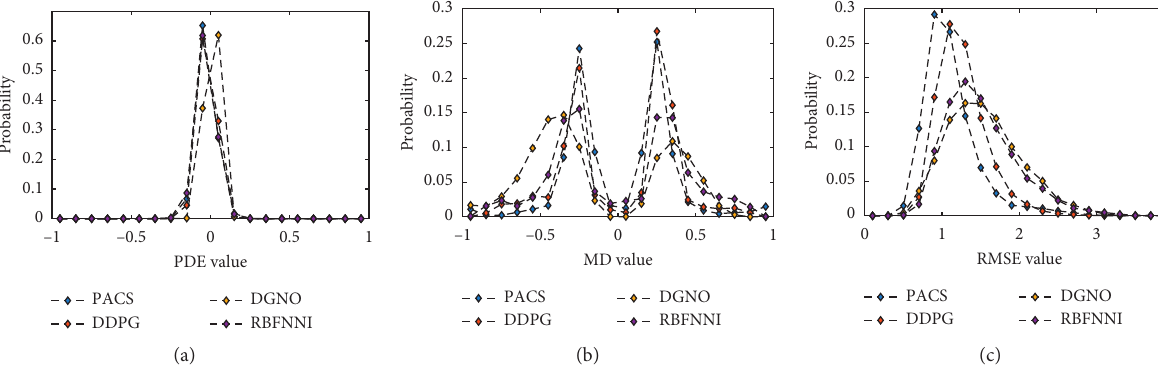
Figure 14: Results shown as distribution of error definitions from different reconstruction methods. (a) PDE. (b) MD. (c)